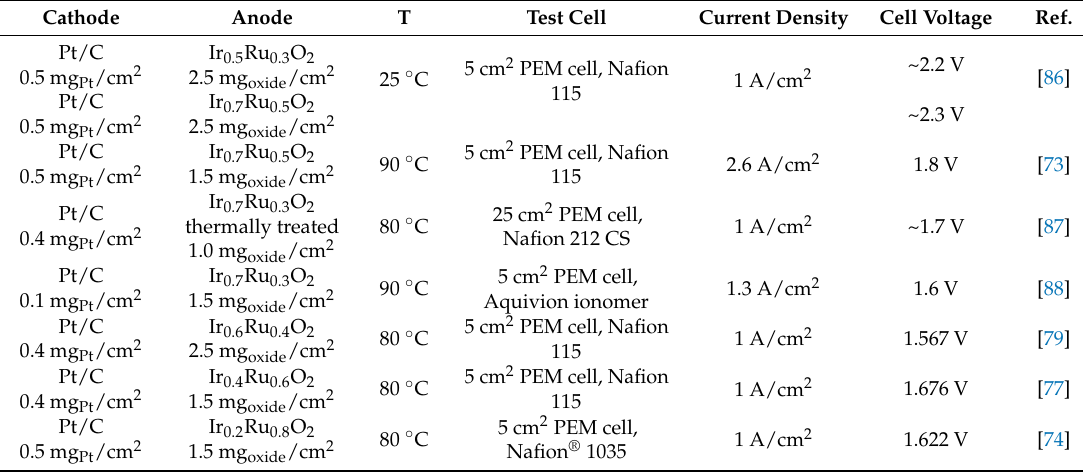
Table 2. PEM electrolyzers with state-of-the-art electrocatalysts.